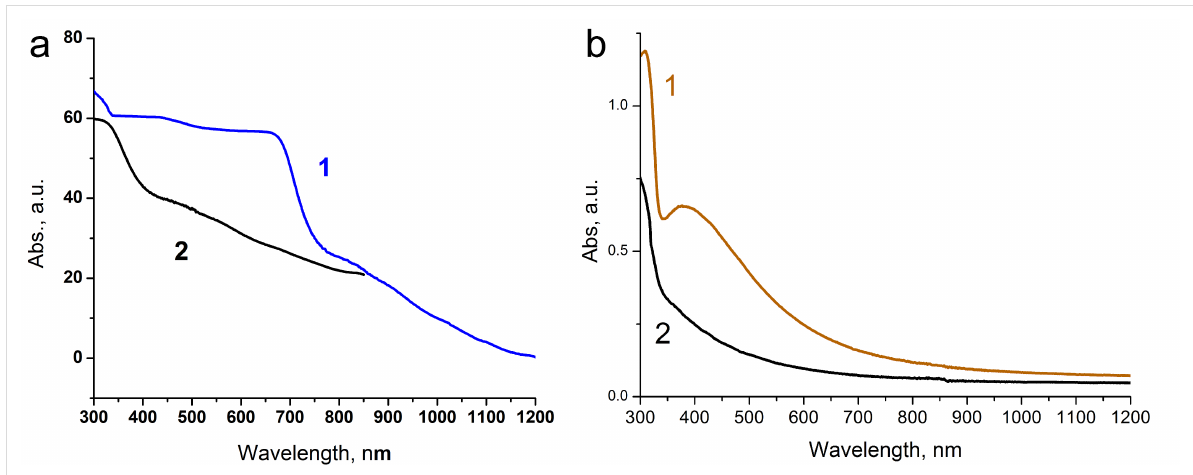
Figure 3: Optical absorbance spectra replotted from total reflectance data collected by an integrating sphere ( d = 150 mm): (a) (1) reduced by NaBH 4 silver and (2) pristine Ag 2 O polycrystals, and (b) (1) mp-Ag/Ag (PVP) film, (2) pristine Ag 2 O film.